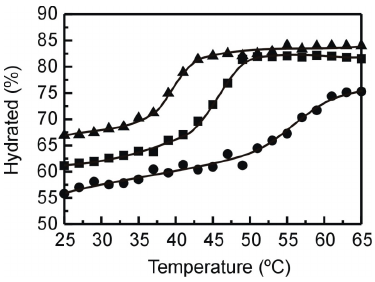
Figure 7. Proportion of the hydrated component of the carbonyl stretching band as a function of temperature. Pure DMPE ( ● ) and mixtures containing TMCG at 0.07 ( ■ ) and 0.25 ( ▲ ) molar fraction.